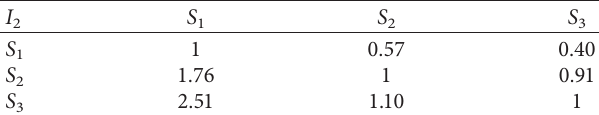
Table 6: Judgment matrix of the strategic layer relative to I